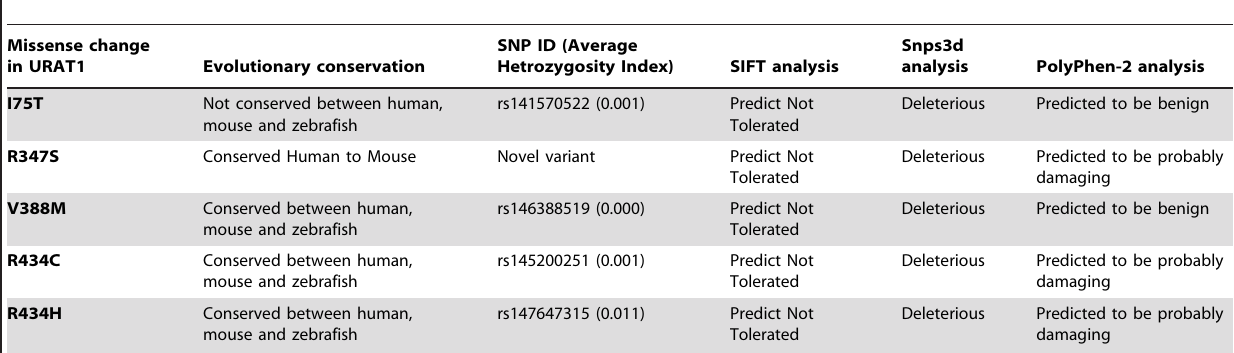
Table 2. URAT1 variants and their in silico analysis for conservation and